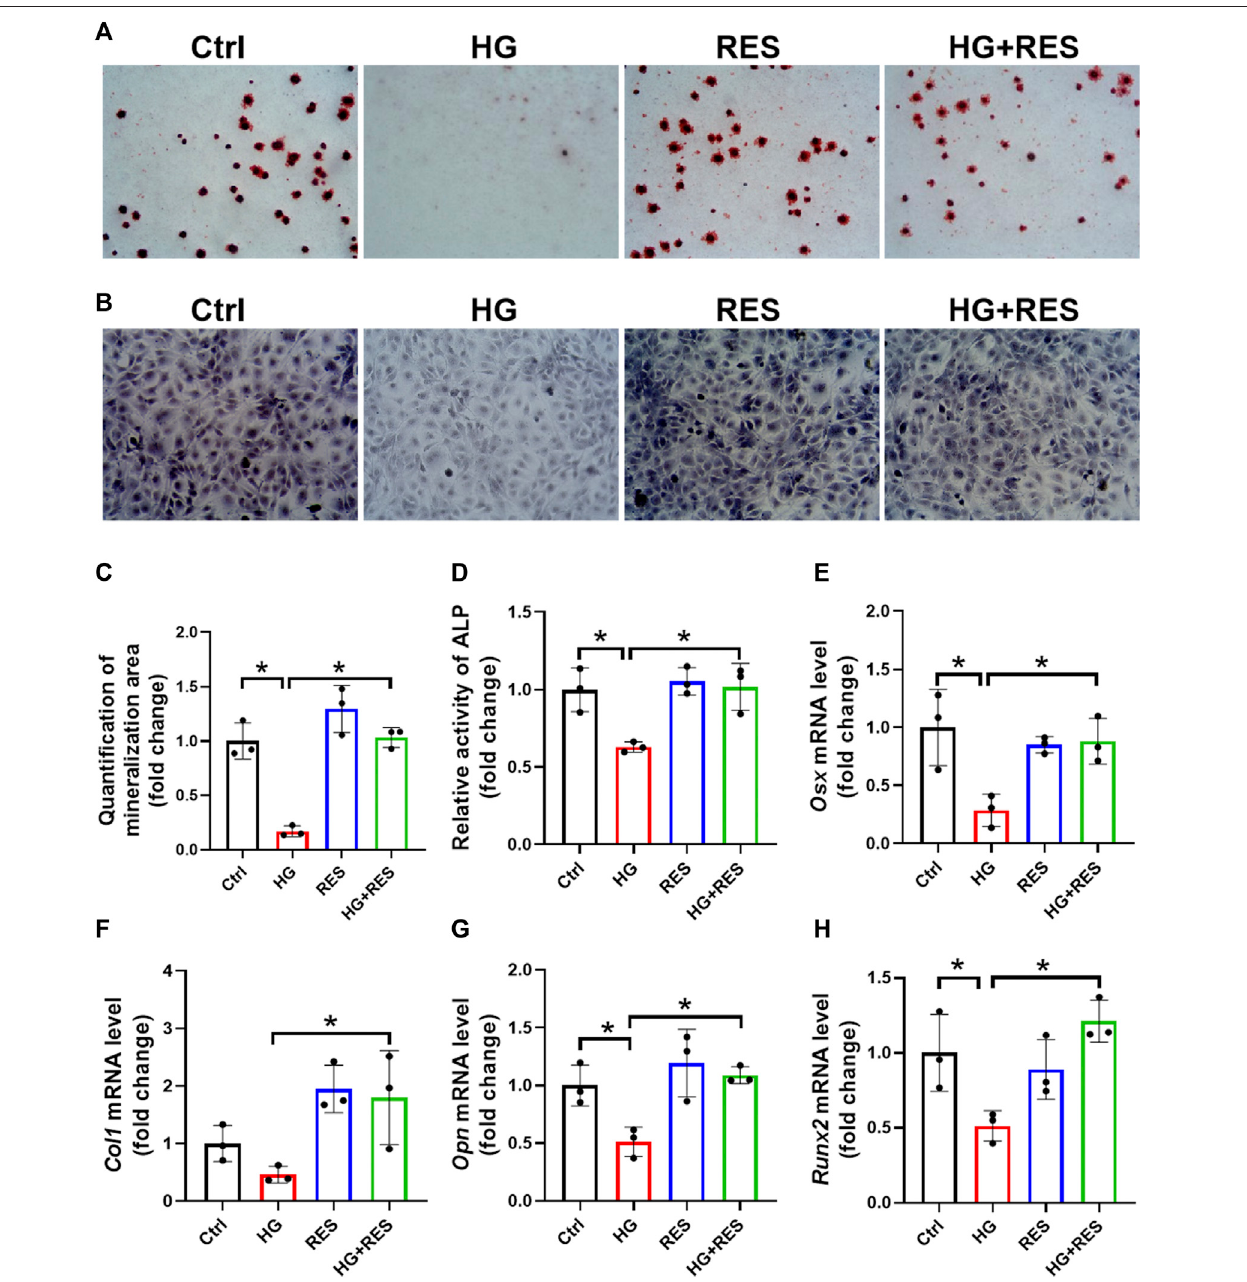
FIGURE 2 | Protection of RES on HG-suppressed osteogenic differentiation. (A – D) MC3T3-E1 cells were treated in an osteogenic differentiation medium in the presenceorabsenceof30 mMHGand(or)5 μ MRESfor14 days. (A,C) Representativeimagesofalizarinredstainingandquali fi cationofmineralizationareafordifferent groups. Three independent experiments were performed. (B) Representative images of alkaline phosphatase (ALP) staining. (D) Detection of ALP activity. Three independentexperimentswereperformed. (E – H) mRNAlevelsofosterix( Osx ),collagen1( Col1 ),osteopontin( Opn ),andrunt-relatedtranscriptionfactor 2( Runx2 ) were detected by RT-qPCR. Three independent experiments were performed. Data are shown as mean ± SD. * p < 0.05.